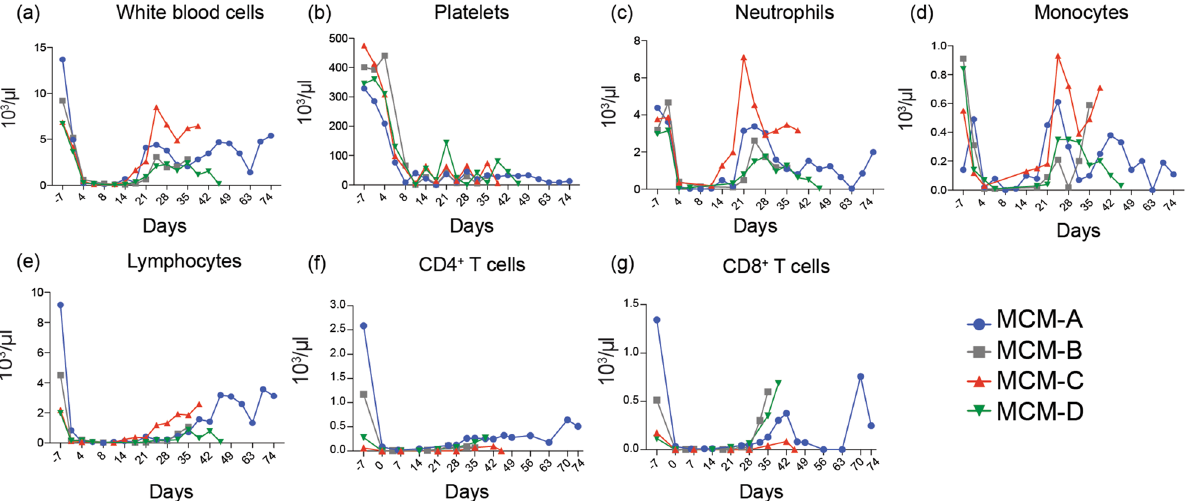
Figure 2. Effect of allo-HSCTs on cell populations and platelets. Longitudinal absolute counts of ( a ) white blood cells, ( b ) platelets, ( c ) neutrophils, ( d ) monocytes, ( e ) lymphocytes, ( f ) CD4 + T cells, and ( g ) CD8 + T cells after allo-HSCTs. Counts are displayed as × 10 3